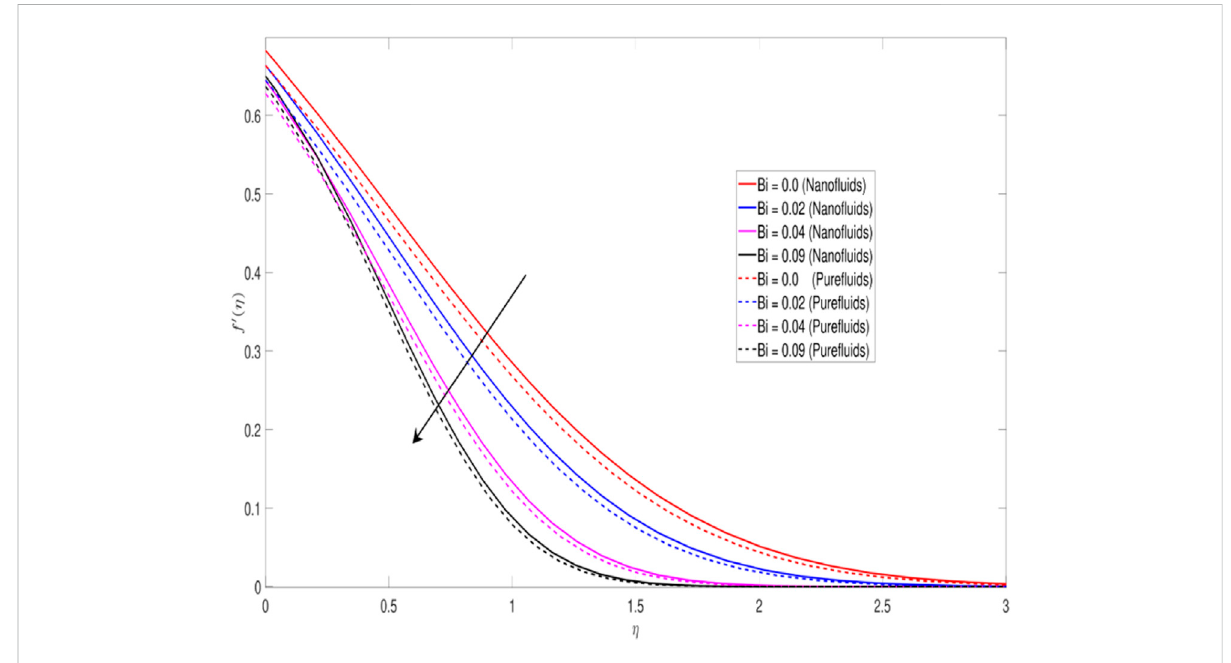
FIGURE 5 Velocity pro fi le in relation to changes in the Biot number.